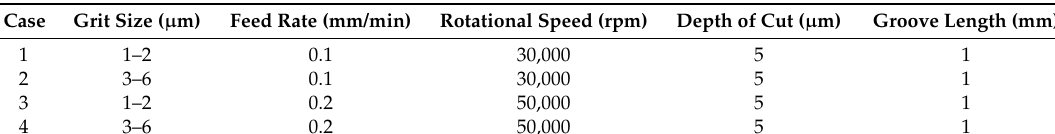
Table 3. Parameters used in the case study.